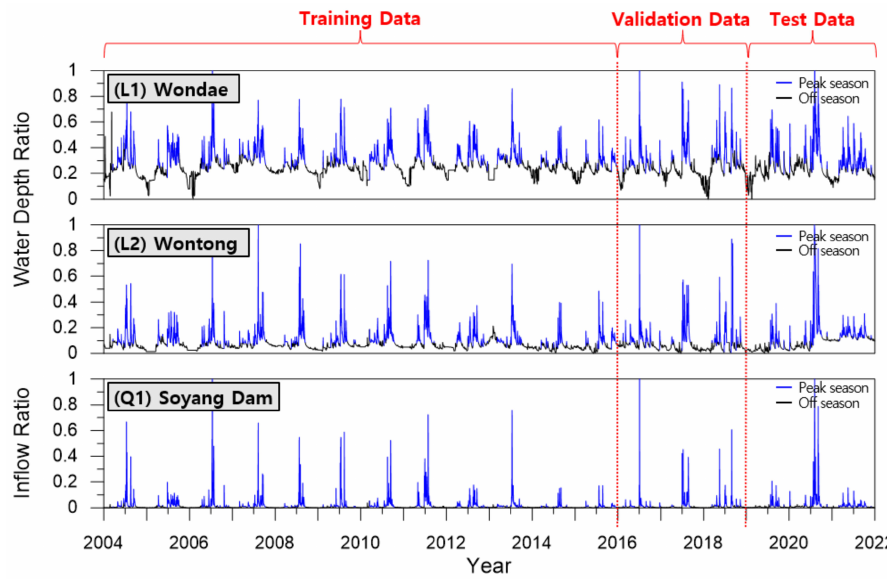
Figure 6. Entire input